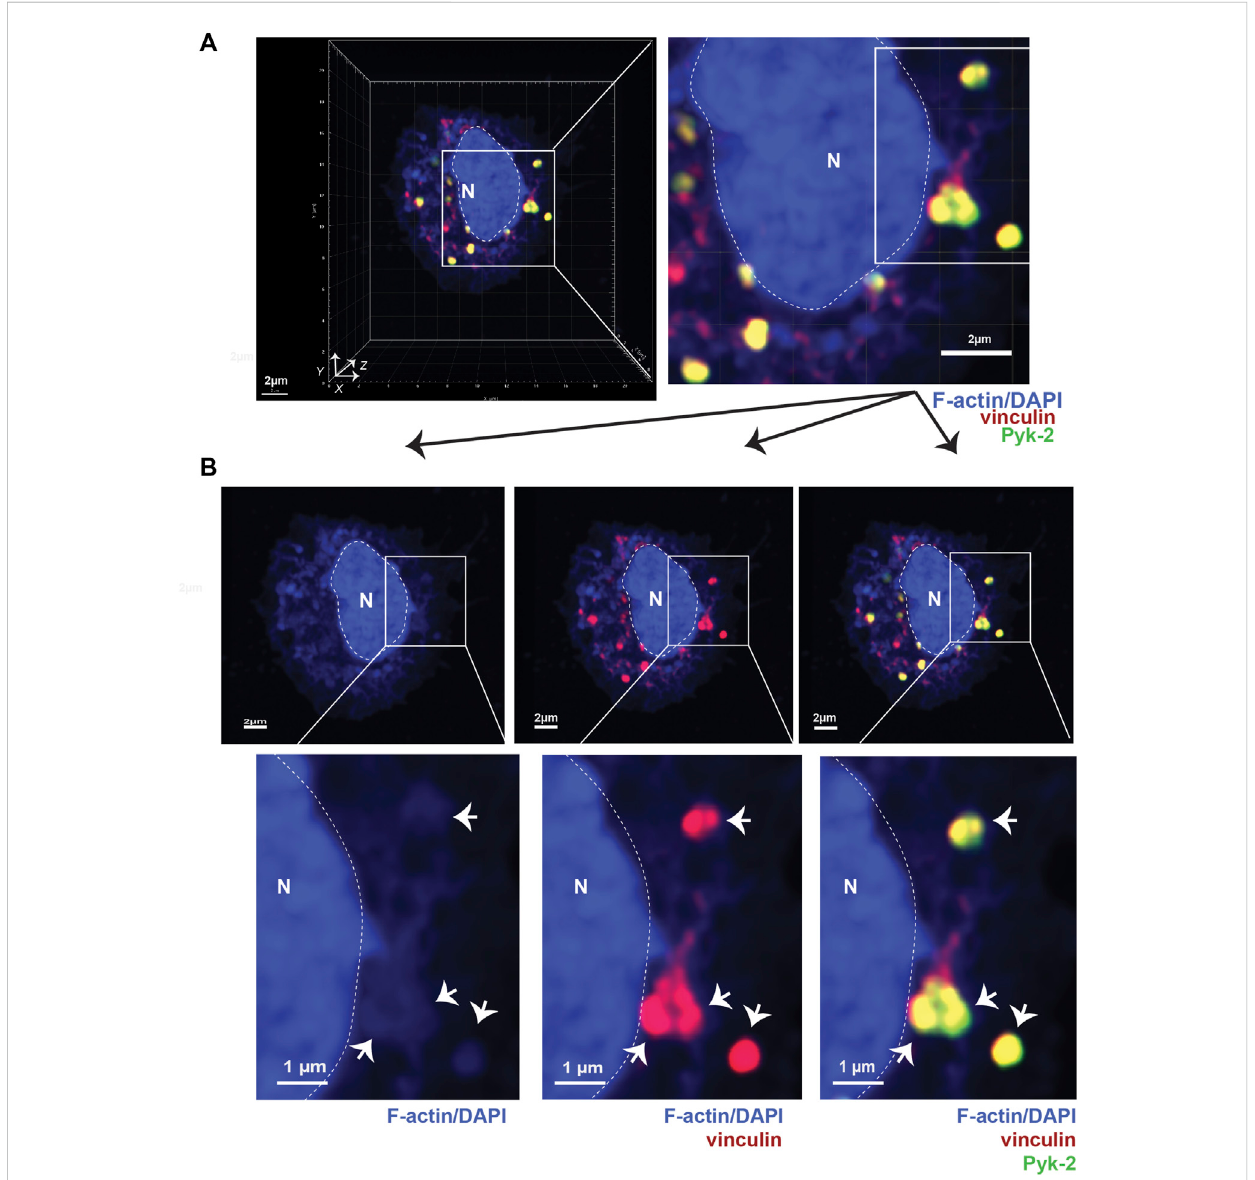
AMs to visualize cellular location of F-actin (blue), vinculin (red), and Pyk2 (green). DAPI was used to image nucleus. ( “ N ” and dotted line). Imaris software was used to reconstruct 3D image of cell, shown in orthogonal view. Grid shows 2 μ m increments and is optimal for size assessment. (B) Representative 2D X-Y projection of AM in panel A, showing overlay of Pyk2 and vinculin with F-actin in podosomes (arrows). DAPI was used to image nucleus. ( “ N ” and dotted line). Scale bars derived from grid in “ A. ”